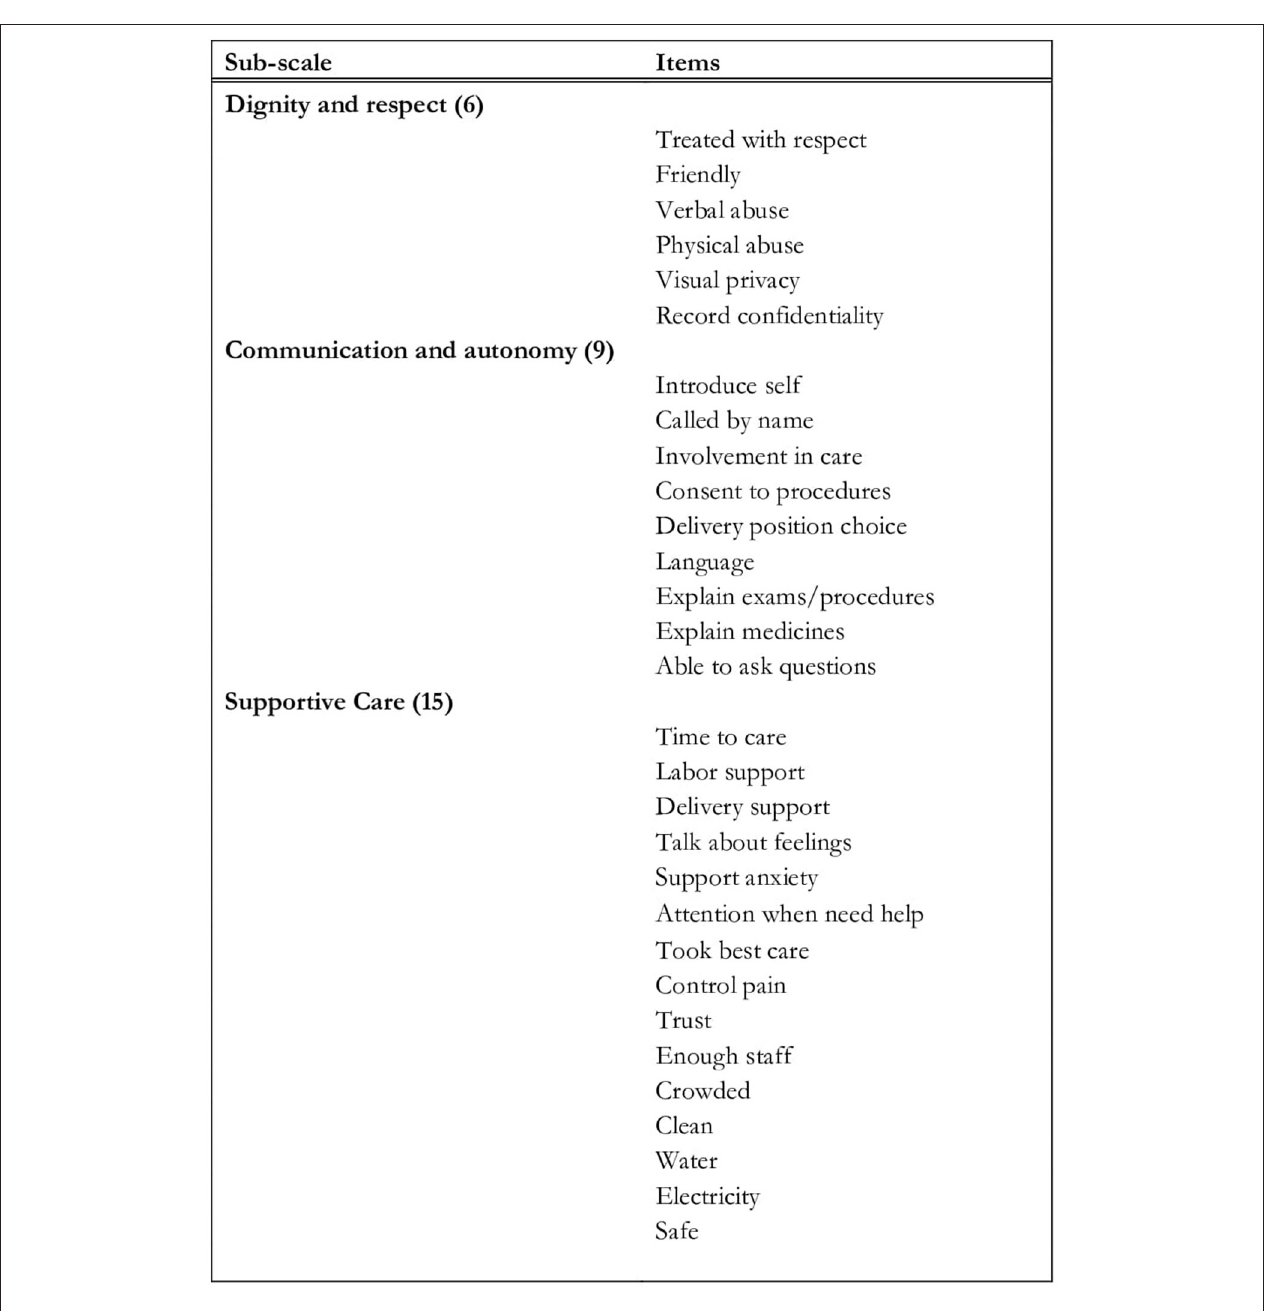
FIGURE 1 | Items from the 30-item PCMC scale by